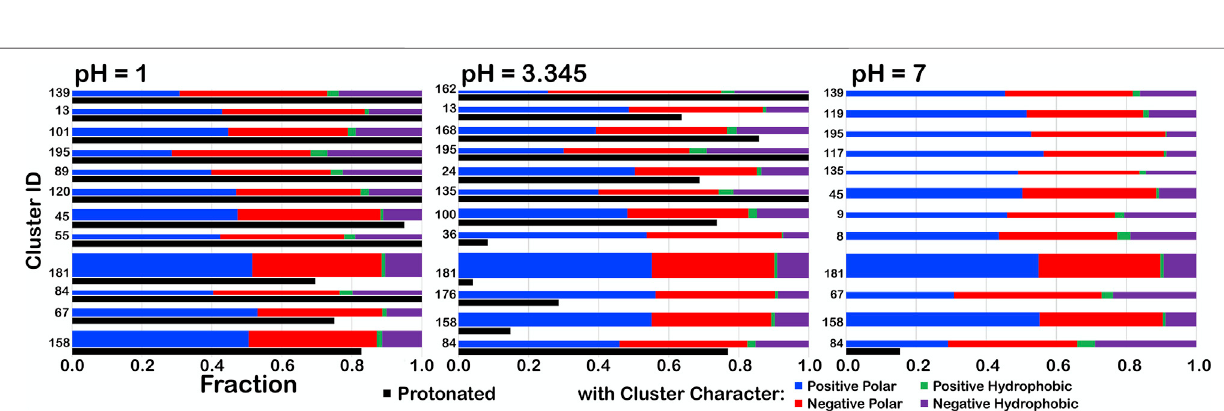
Frontiers in Molecular Biosciences |